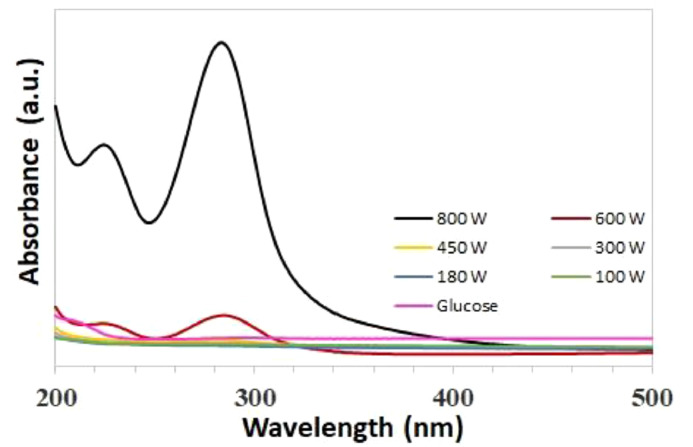
Effect of microwave power (100 W – 800 W) on the synthesis of GQD.